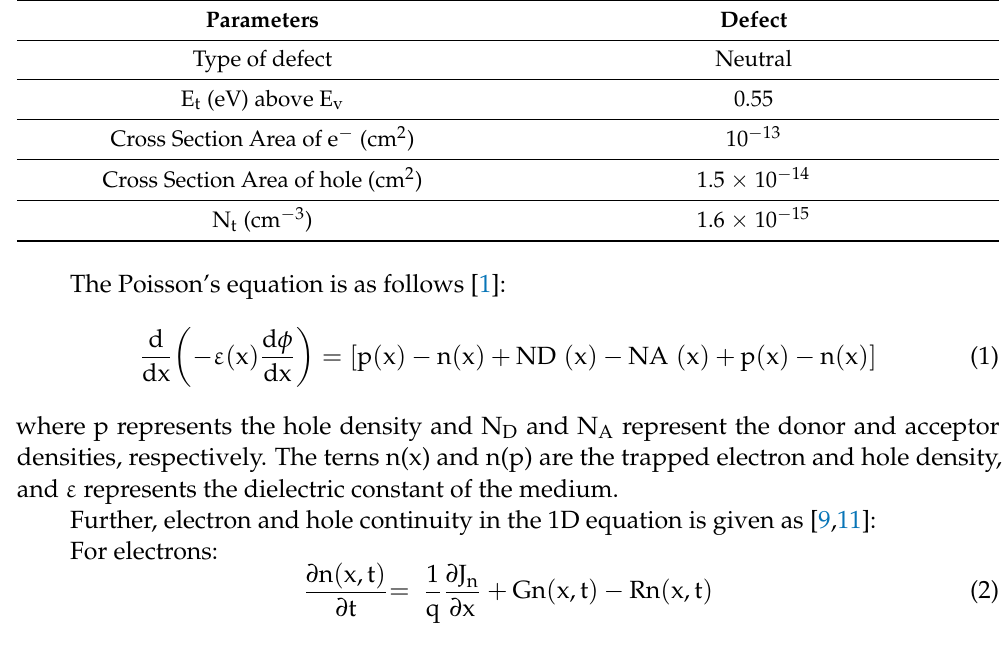
Table 3. The Sb 2 Se 3 trap state parameters for SCAPS simulation